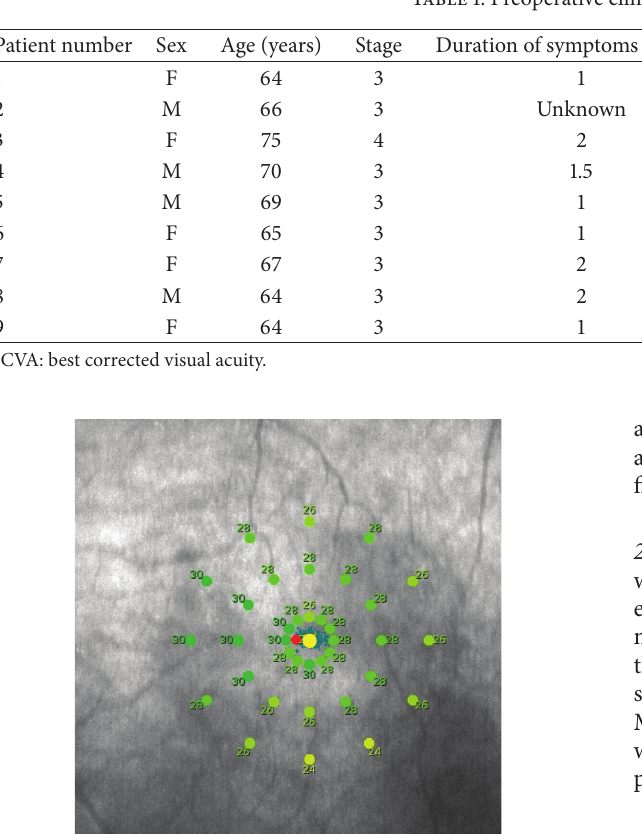
Table 1: Preoperative clinical characteristics.